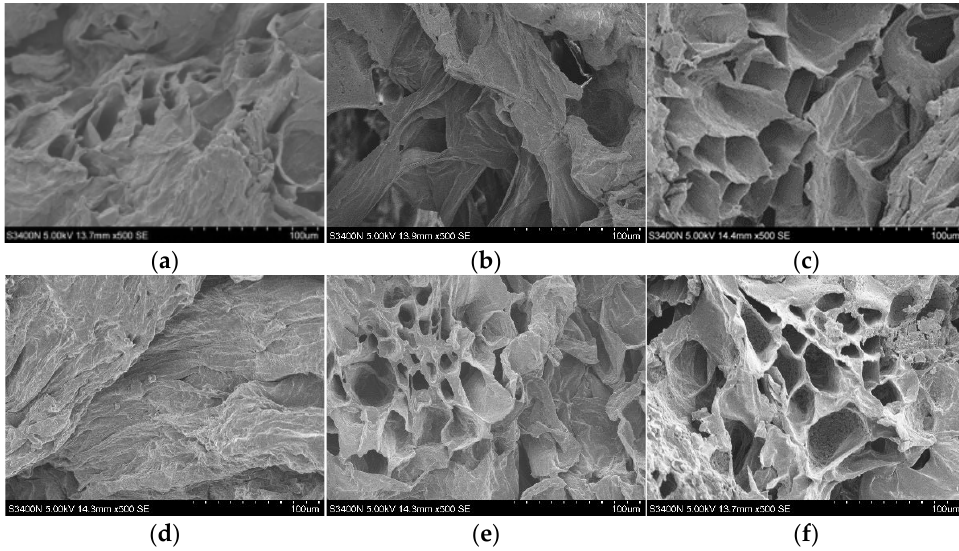
Figure 5. Scanning electron microscope images of Codonopsis pilosulae with different drying methods. The magnification was set as 500×. ND: natural drying; RMVD: rotary microwave vacuum drying; RFVD: radio frequency vacuum drying; VD: vacuum drying; VFID: vacuum far infrared drying. ( a ) ND; ( b ) VFID; ( c ) RFVD; ( d ) HD; ( e ) RMVD; ( f ) VD.